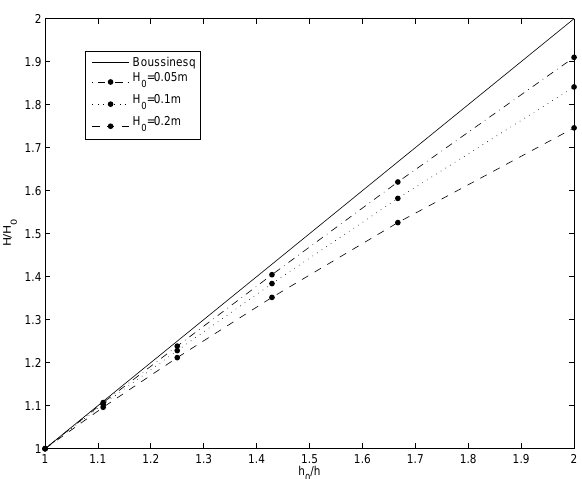
Fig. 2. Computations for the shoaling of solitary waves from rela- Figure 2: Computations for the shoaling of solitary waves from relation (3.6). The solid line tion Eq. (23). The solid line depicts the shoaling relation according depicts the shoaling relation according to Boussinesq’s law. Shoaling rates for waves of initial to Boussinesq’s law. Shoaling rates for waves of initial waveheight waveheight H 0 = 0 . 05m, 0 . 1m and 0 . 2m are computed. As the waveheight of the incident H 0 = 0 . 05m, 0 . 1m and 0 . 2m are computed. As the waveheight solitary waves decrease, the shoaling relation approaches Boussinesq’s result. of the incident solitary waves decreases, the shoaling relation ap- proaches Boussinesq’s